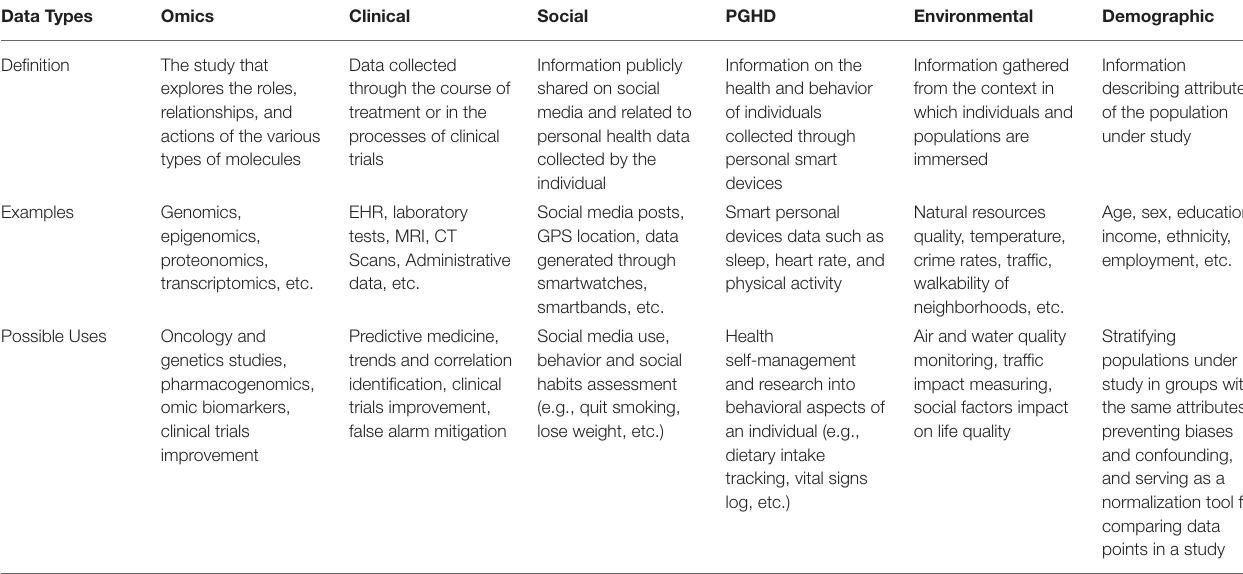
TABLE 1 | Data Types Identified in the Literature